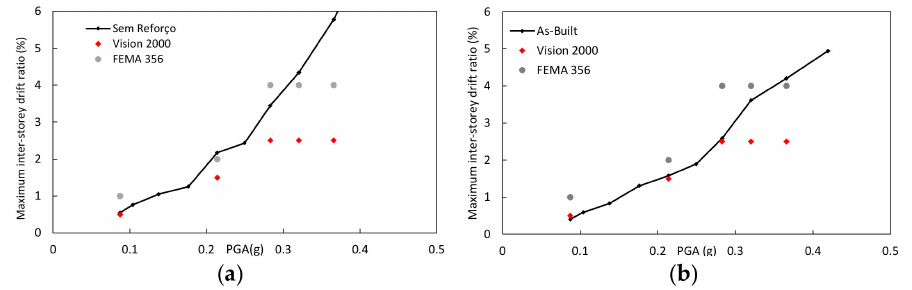
Figure 28. Non-linear dynamic analysis results: Maximum inter-storey drift ratio ( a ) longitudinal direction and ( b ) transverse